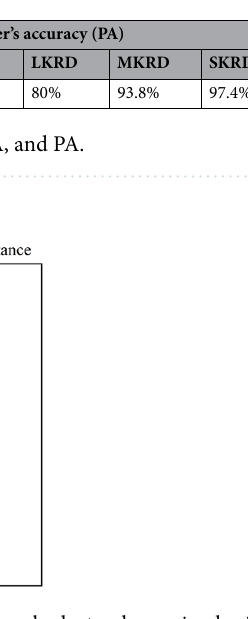
Figure 4. The importance of feature factors of KRD in the peak-cluster depression basin in southwest Guangxi,